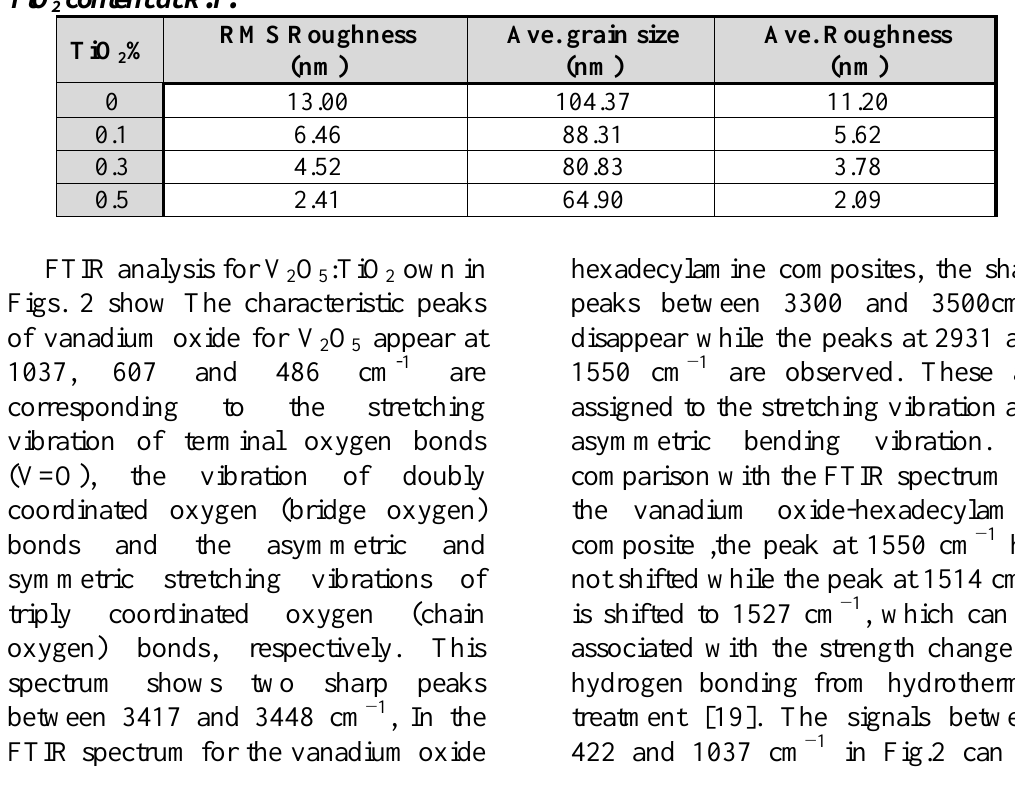
content (x=0, 0.1, 2 O ) (TiO ) films with different 2 5 1-x 2 x